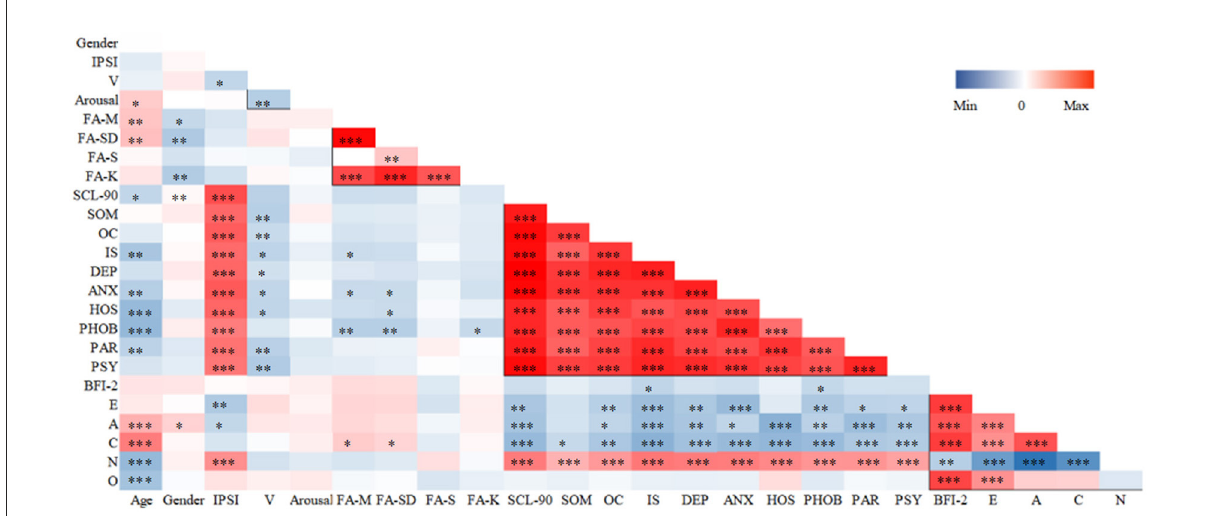
FIGURE4 Relationship between participants’ psychological scale scores and multimodal data. * p < 0.05, ** p < 0.01, *** p < 0.001. IPSI, Interview Psychological Symptom Inventory; V, valence; PA-M, the mean of Physical Activity; PA-SD, the standard deviation of Physical Activity; PA-S, the skewness of Physical Activity; PA-K, the kurtosis of Physical Activity; SOM, Somatization; OC, Obsessive-Compulsive; IS, Interpersonal- Sensitivity; DEP, Depression; ANX, Anxiety; HOS, Hostility; PHOB, Phobic Anxiety; PAR, Paranoid Ideation; PSY, Psychoticism; E, Extraversion; A, Agreeableness; C, Conscientiousness; N, Neuroticism; O,